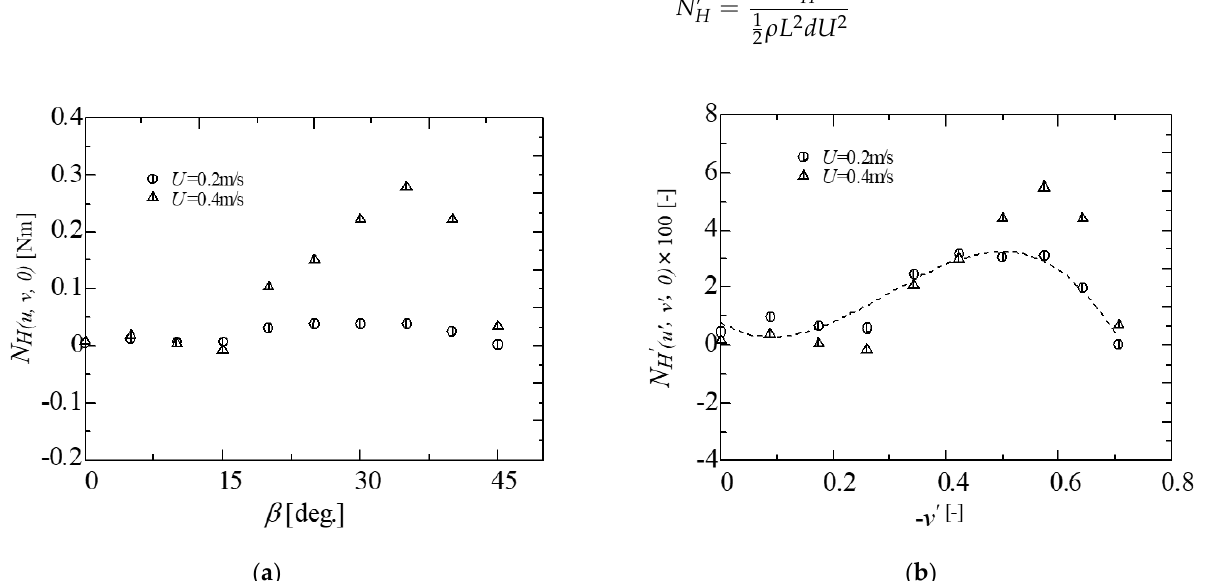
Figure 10. ( a ) Variation of the yaw moment along the z -axis with the drift angle; ( b ) Variation of the dimensionless yaw moment along the z -axis with v ′ .